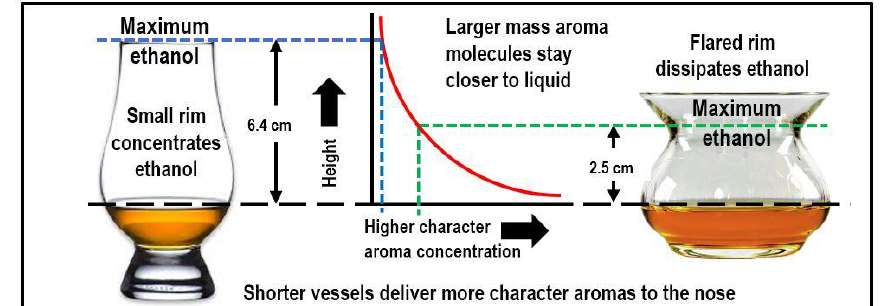
Figure 3. Short vessels deliver more character aroma. Open systems have lower concentration of higher-mass molecules near the rim than at the liquid surface. The difference in mass between ethanol at 46.07 gm/mole and an oak lactone at 264.26 gm/mole translates to larger masses directionally more abundant closer to the liquid surface. Complex molecules (long chains, higher molar mass) have greater difficulty moving upwards due to gravitational effects and imperfect molecular collisions. Ethanol concentration of total aroma increases as nostril position moves higher above the liquid surface. Short vessels improve heavier complex molecule detection. The majority of spirit aromas available are detectable when the distance between liquid surface and rim or maximum concentration plane is under 2.5 cm Table 6. New aromas detected in bourbon as nose moves closer to liquid surface. Determined empirically, 2.5 cm is the maximum critical distance for complete aroma detection. Fluid levels were adjusted to decrease distance between liquid surface and rim plane in a large graduated tumbler. Panelists recorded new smells detected at each level. Tests were repeated with different control spirits yielding similar results. The control spirit shown is a common 40% ABV bourbon. See Section 2, Methods. Distances above 2.5 cm significantly affect aroma detectability.